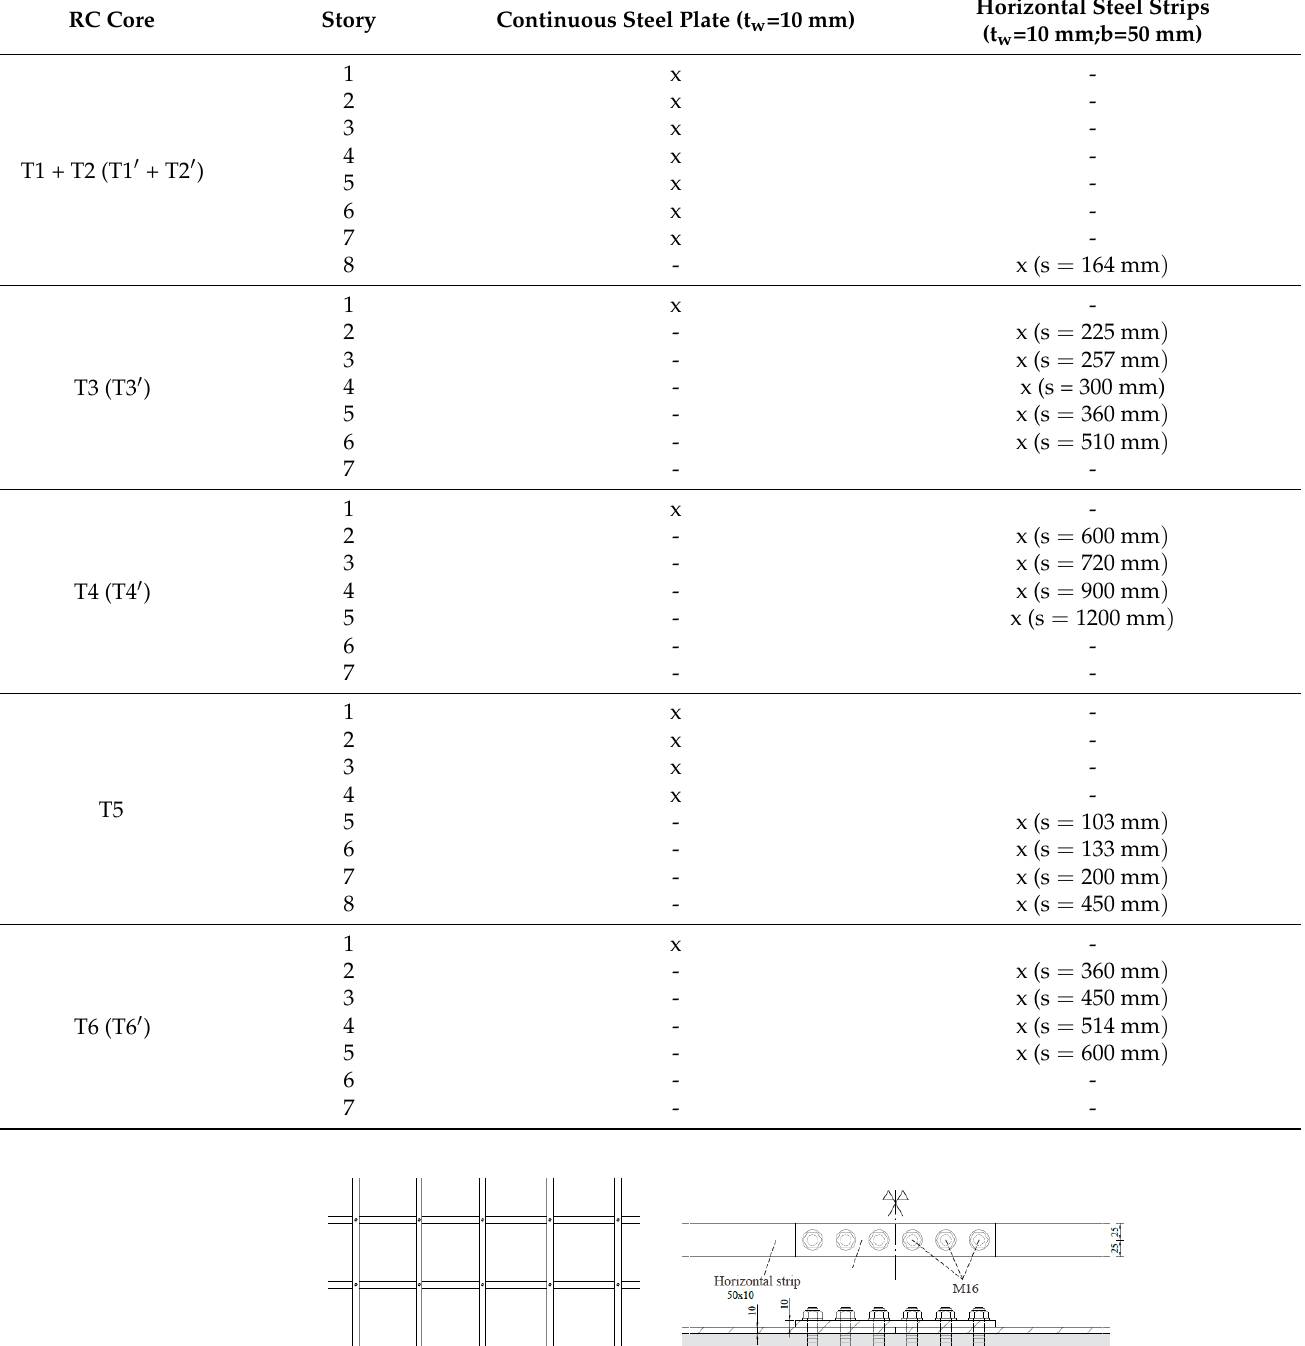
Table 13. Disposition of steel plates and strips in I2 ( ζ E ≥ 1.00).